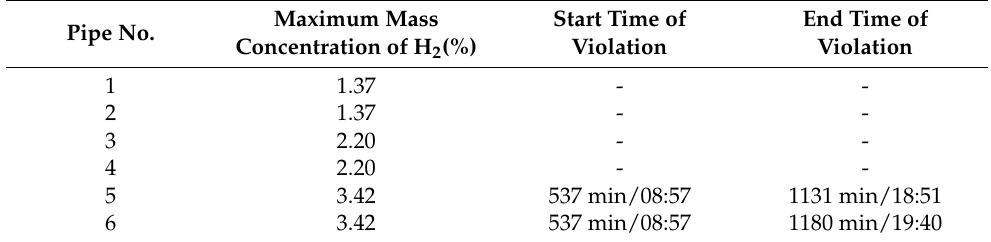
Table 3. The results of hydrogen concentration violation of each pipe in Scenario III. Pipe No.